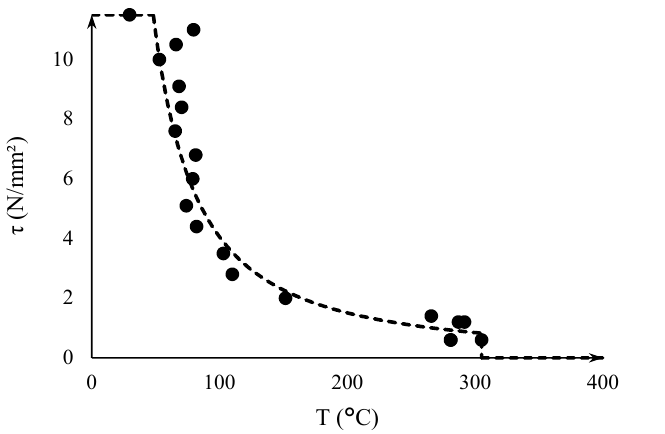
Figure 7. Representation of stress distribution along the anchor at different times during heating [16].